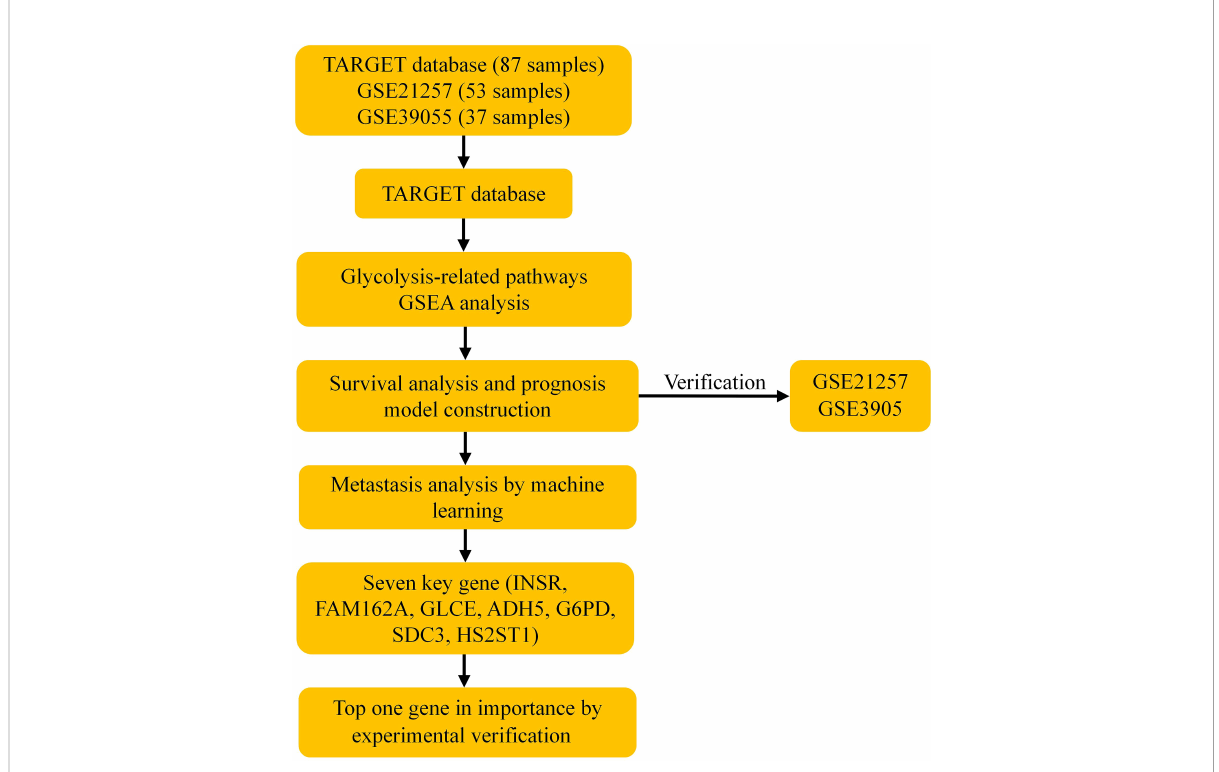
FIGURE 1 Schematic work fl ow of a risk model for osteosarcoma prognosis constructed based on glycolysis-related genes. GSEA, Gene set enrichment